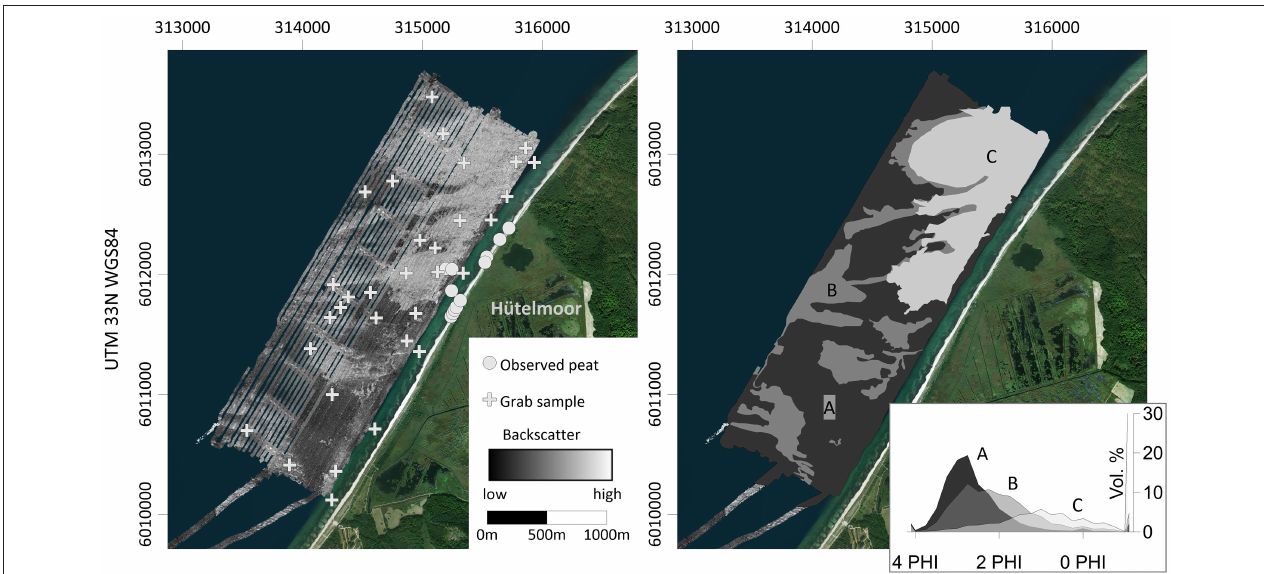
FIGURE 3 | (Left) Available backscatter data with grab samples for surficial ground truthing and near-coastal peat observations. (Right) Manual clustering of the backscatter data into three seafloor facies A–C. Representative grain size distributions for each facies are displayed, with A fine sand (black), B gravelly medium sand (gray), and C gravelly coarse sand (light gray). The insert in the (Right) panel indicates the grain size distribution (PHI-scale) in Vol %.